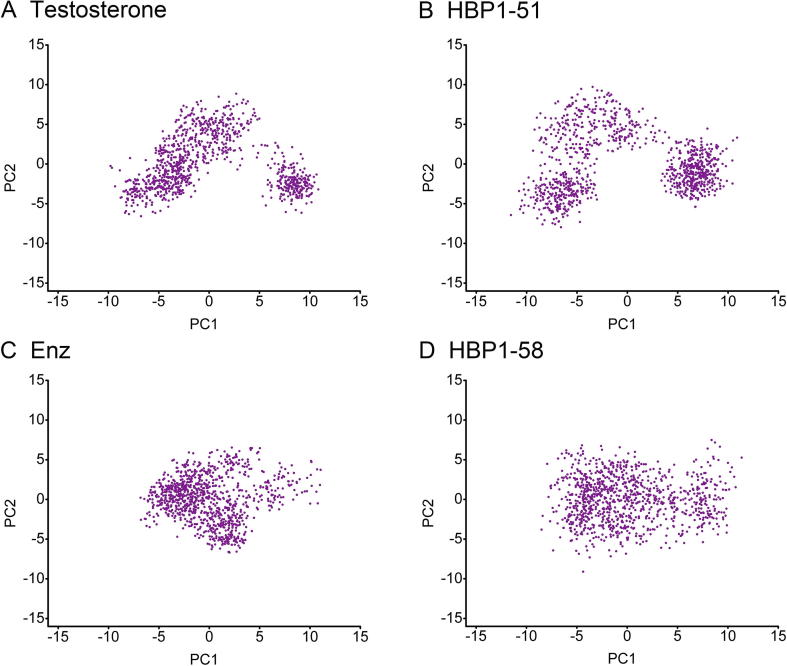
Principal components analysis of the Cα atoms of the AR conformational motions during simulationThe cloud represents the last 10 ns of trajectories projected onto the first two eigenvectors for the AR/testosterone (A), AR/HBP1-51 (B), AR/Enz (C), and AR/HBP1-58 (D). The distribution of dots indicates the conformational changes in the system, with each dot representing a snapshot from MD simulation trajectory. MD, molecular dynamics.